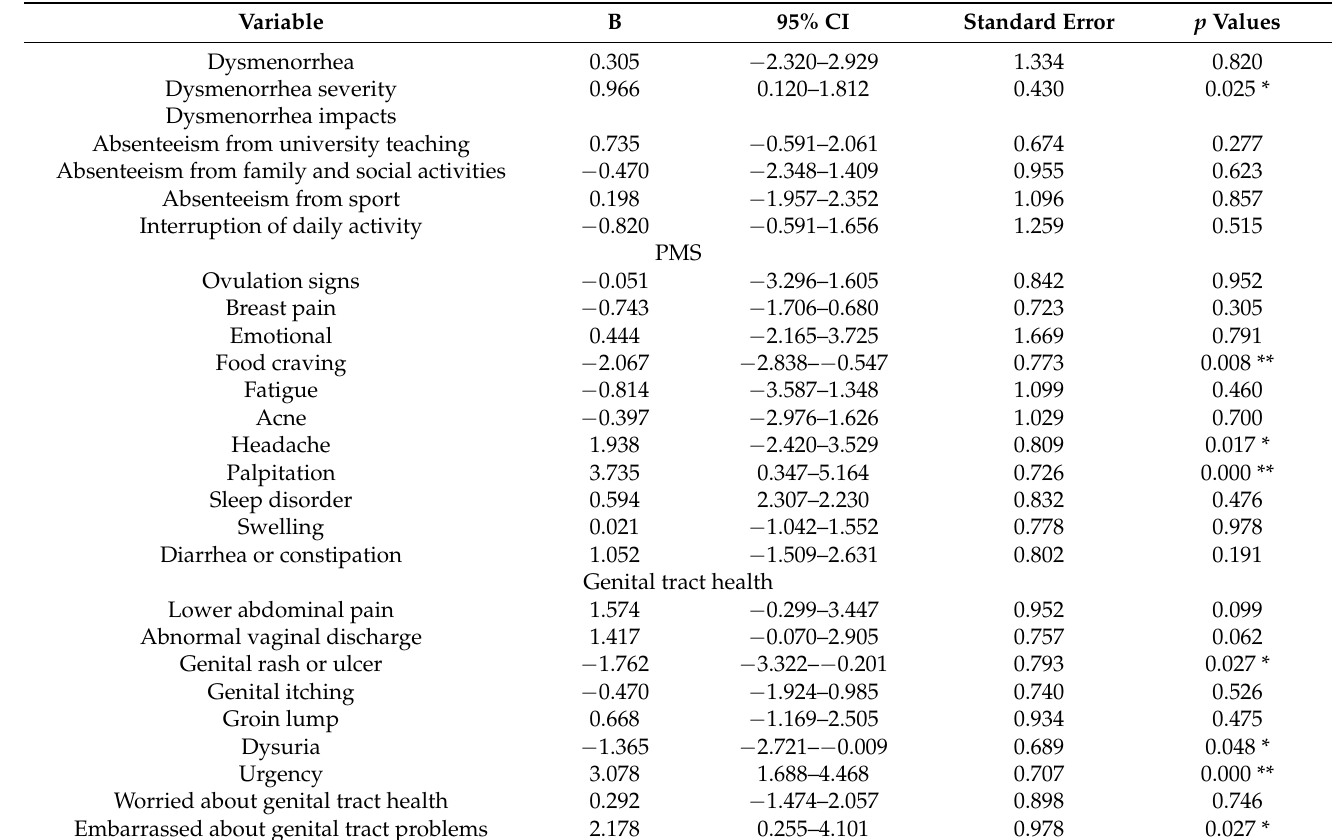
Table 6. Associations between dysmenorrhea, PMS, and genitourinary symptoms during COVID-19 with anxiety scores using multiple linear regression model.